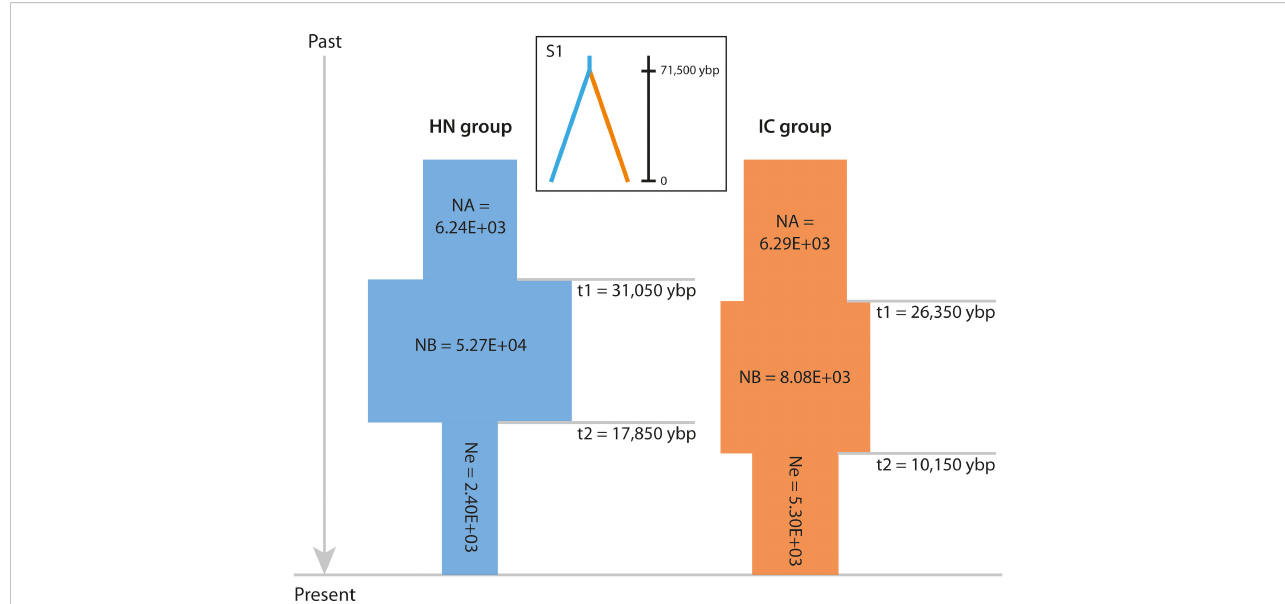
FIGURE 5 Schematic representation of the demographic history of the HN and IC groups under the best- fi t ABC model. NA indicates large ancestral population size, NB indicates expanded historic population size, and Ne indicates current population size. Times of population size changes are indicated by horizontal grey lines and population size estimates (number of individuals) are shown in each block. Best- fi t divergence scenario S1 is shown inset. Ybp, years before